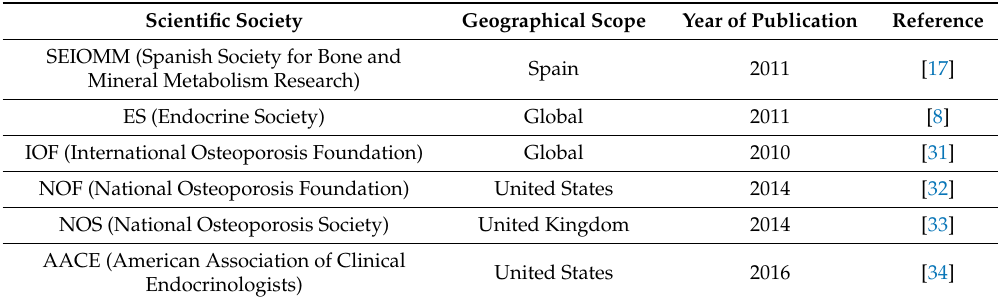
Table 1. List of relevant national and international scientific societies specialized in the clinical management of osteoporosis that recommend cholecalciferol as the vitamin D form of